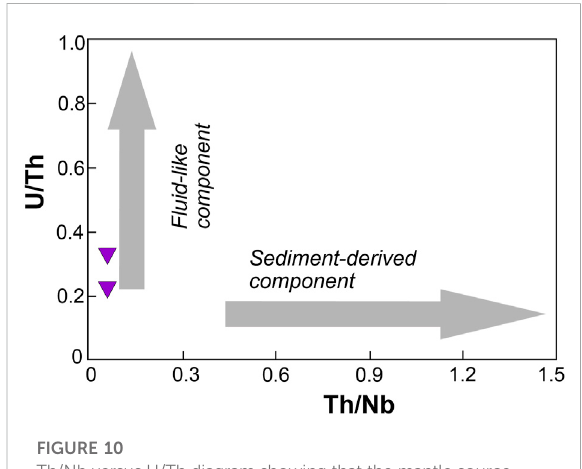
FIGURE 10 Th/Nb versus U/Th diagram showing that the mantle source ofthediabase dikeswasmetasomatizedbyslab-released aqueous fl